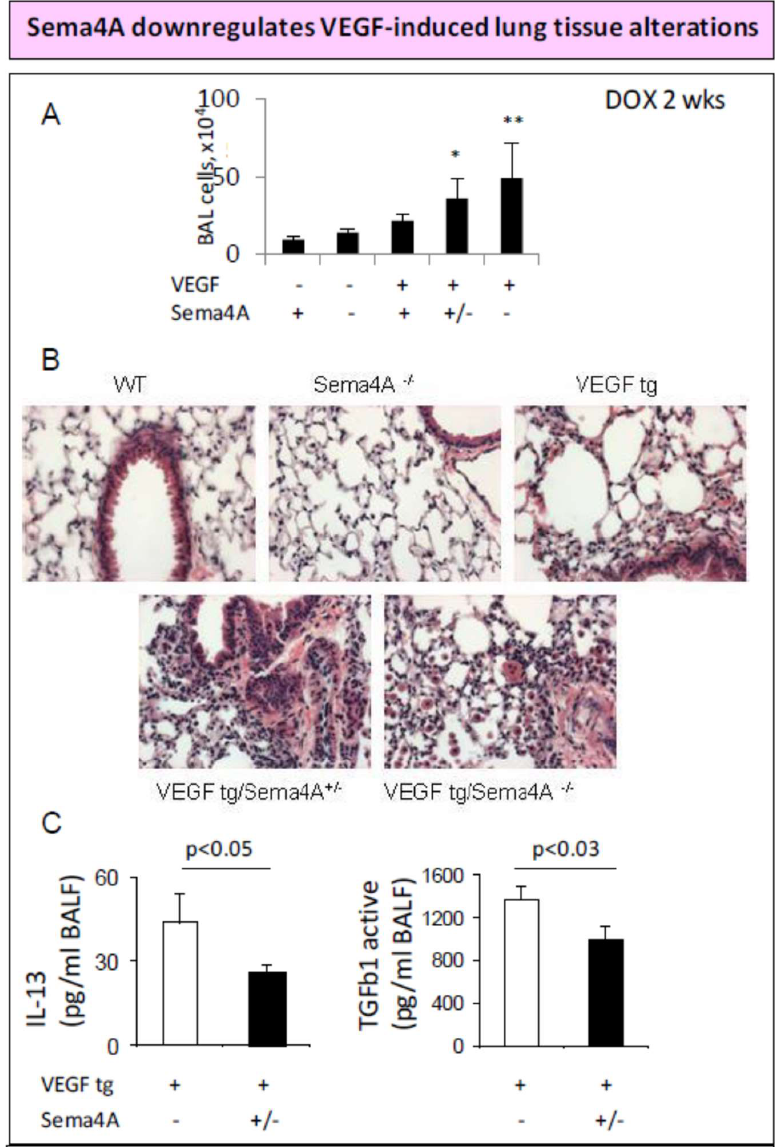
Figure 3. Increase in lung pathology in VEGF tg mice with Sema4A deficiency. ( A ) Broncho-alveolar lavage (BAL) fluids were harvested and the total cell counts were performed with hemacytometer. * p < 0.03, VEGF tg/ Sema4A +/ − mice vs. VEGF tg mice; ** p < 0.05, VEGF tg/Sema4A − / − mice vs. VEGF tg mice. N = 3–4 animals/experimental group. ( B ) Lung sections were stained with H&E. Photomicrographs of 40 × magnification H&E stained lung sections were taken. ( C ) IL-13 and